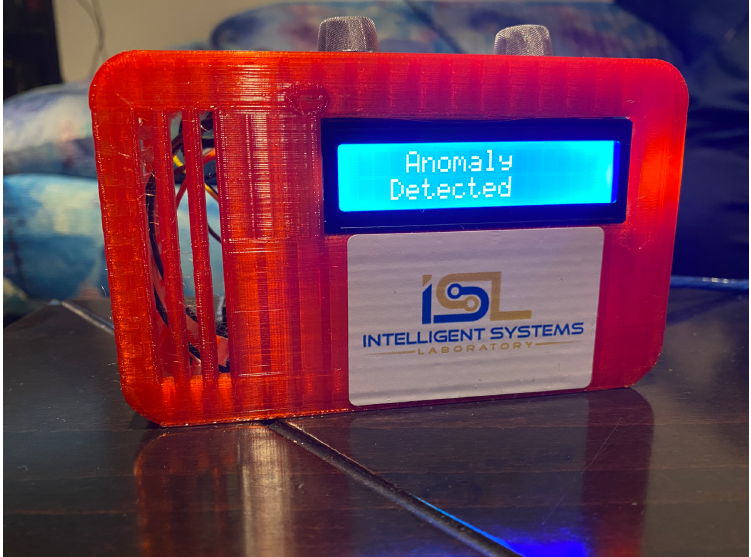
Figure 3. An anomaly detected from the